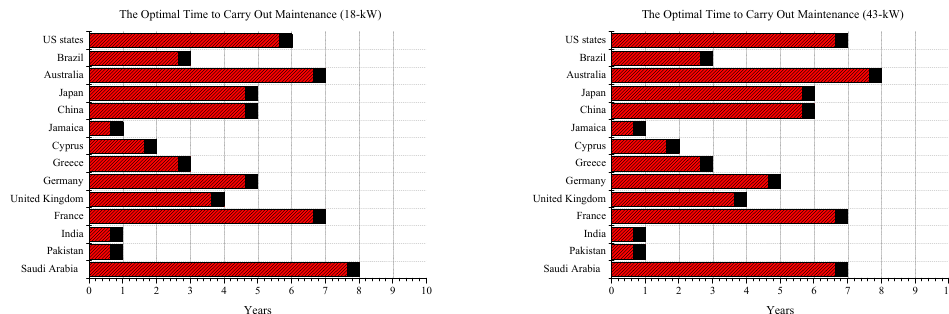
Figure 12. The year identified by the suggested algorithm as the optimal time to carry out maintenance in order to achieve the greatest economic advantage.